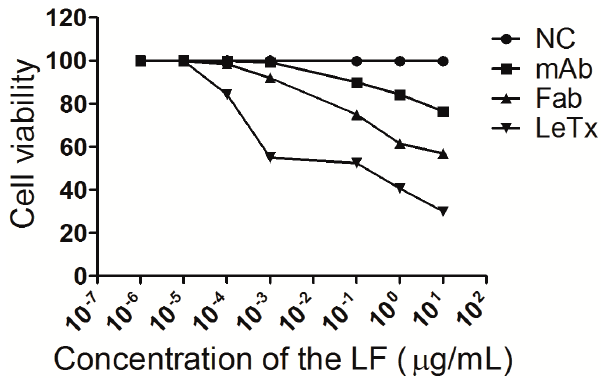
Figure 6. Anthrax LeTx neutralization activity assay of PA6-Fab. The cell protection using 20 μ g murine anti-PA or the PA6-Fab was detected at different concentrations of LeTx. Cells cultured in DMEM alone or with LeTx were used as